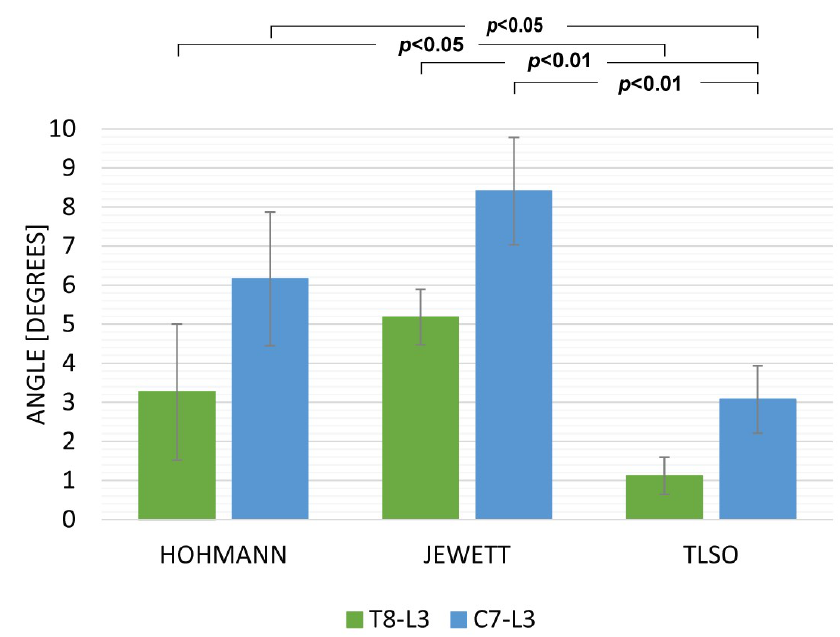
Figure 4. The maximum sagittal inclination while walking.